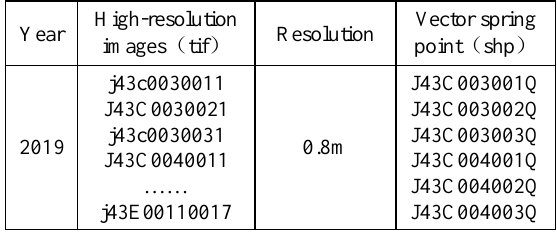
Table 1. Data used in the experiment